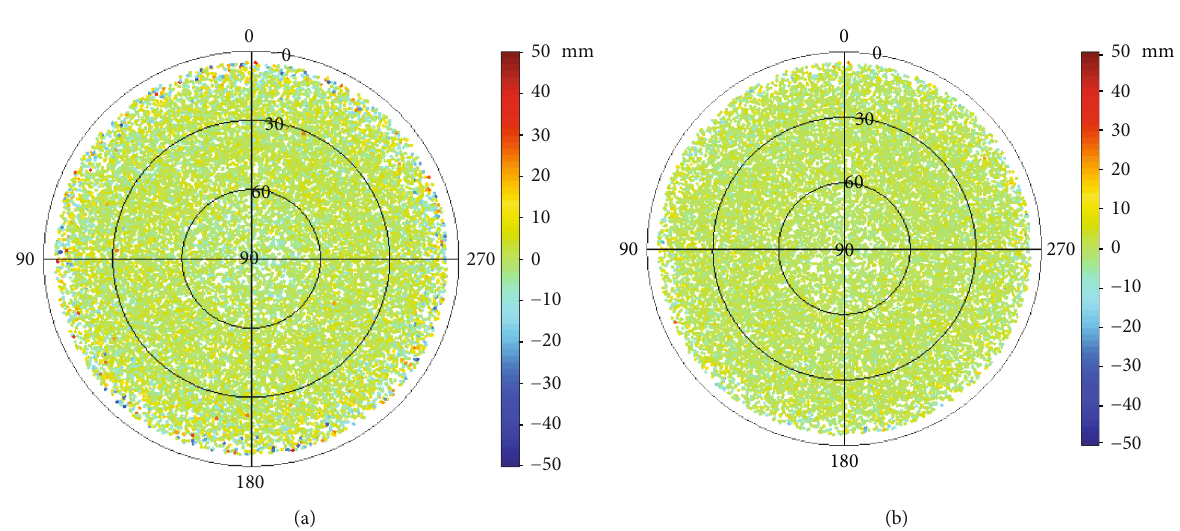
Figure 4: Measurement residuals of GRACE-A: (a) reduced-dynamic and (b) kinematic methods on 12 July 2016.